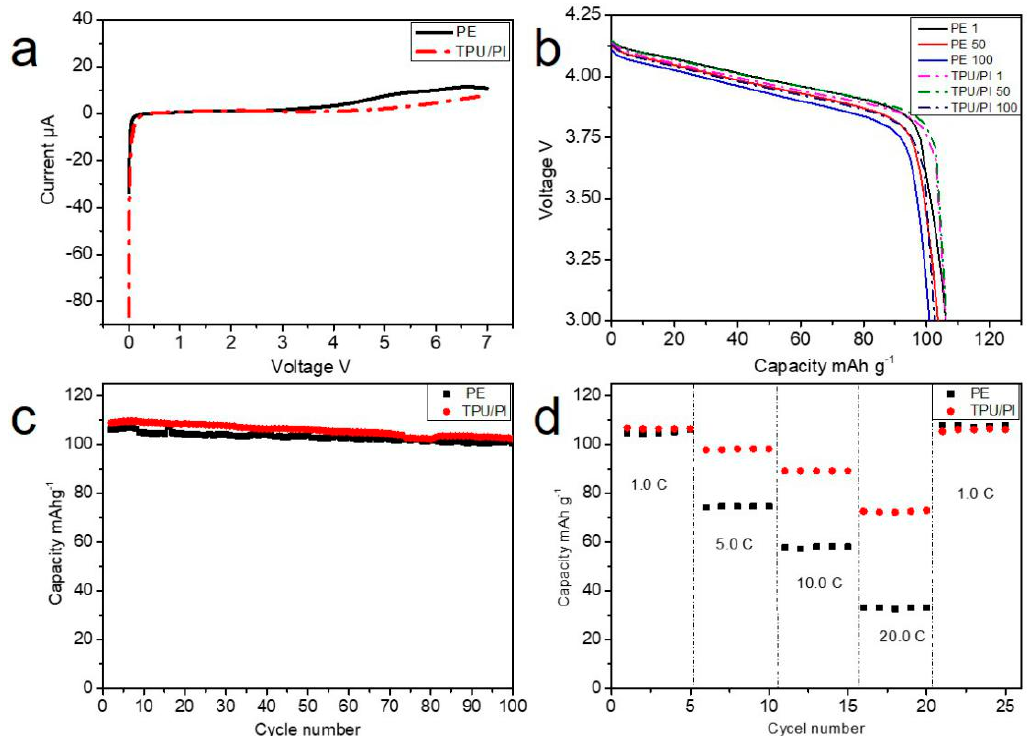
Figure 7. ( a ) LSV of the PE and TPU/PI after saturated with 1 mol·L − 1 LiPF 6 electrolyte. ( b ) 1, 50, 100 cycles discharge curves of the batteries with PE and TPU/PI. ( c ) Cyclic and ( d ) rate performance of batteries with PE and TPU/PI polymer